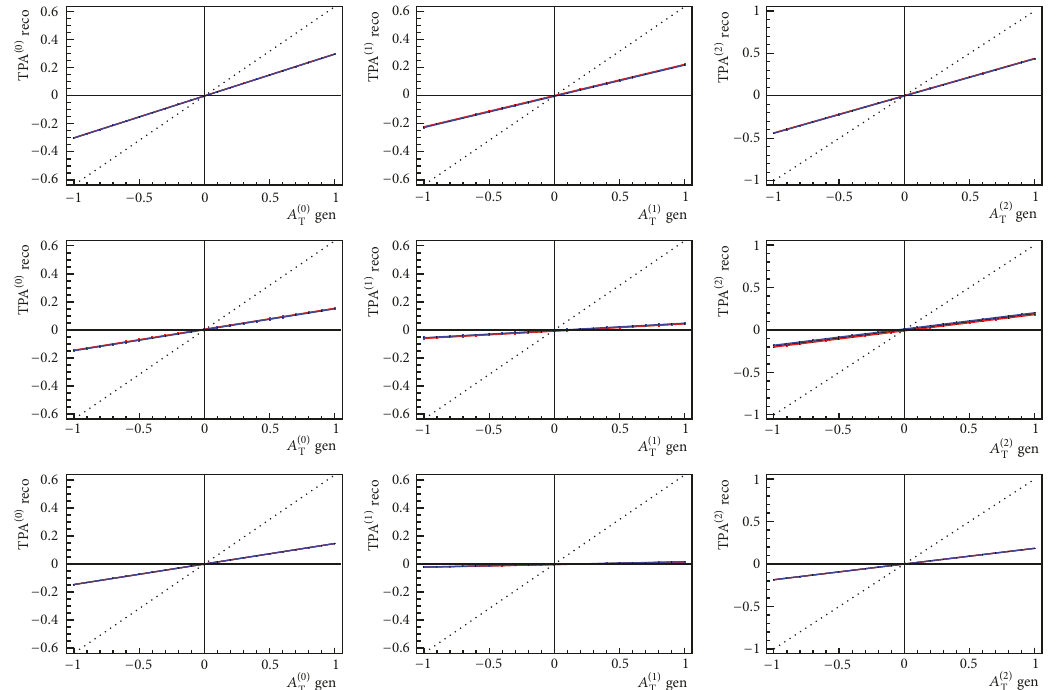
Figure 13: Relation between TPAs and 𝐶𝑃 -violating observables for (top) 𝐵 󳨀→ 𝐷 ∗+ 𝜇 − ] 𝜇 , (middle) 𝐵 󳨀→ 𝐷 ∗+ 𝜏 − (󳨀→ 𝜋 + 𝜋 − 𝜋 − ] 𝜏 ) ] 𝜏 and (bottom) 𝐵 󳨀→ 𝐷 ∗+ 𝜏 − (󳨀→ 𝜇 − ] 𝜇 ] 𝜏 ) ] 𝜏 decays, for three values of the corresponding CP -conserving observables A (𝑖) 𝐶 : (black) 0, (red) 1, (blue) -1. Lines are almost overimposed, showing the relation is independent of the A (𝑖) 𝐶